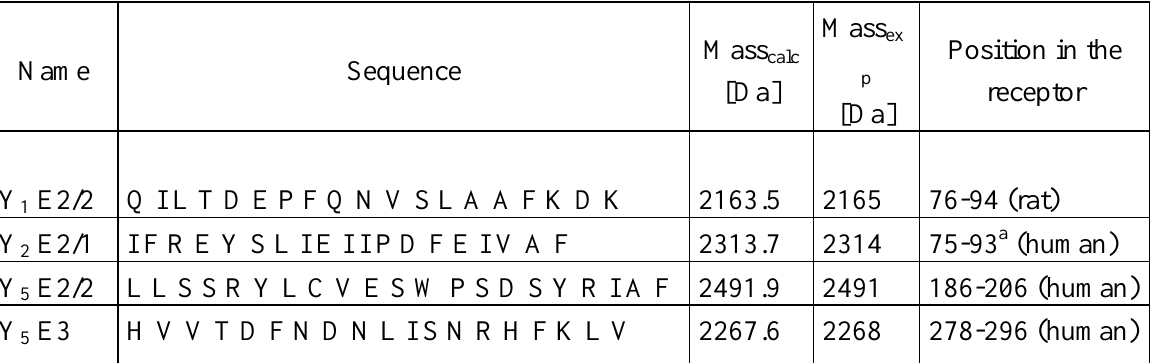
Sequence and analytical data of the peptides used to generate anti-receptor